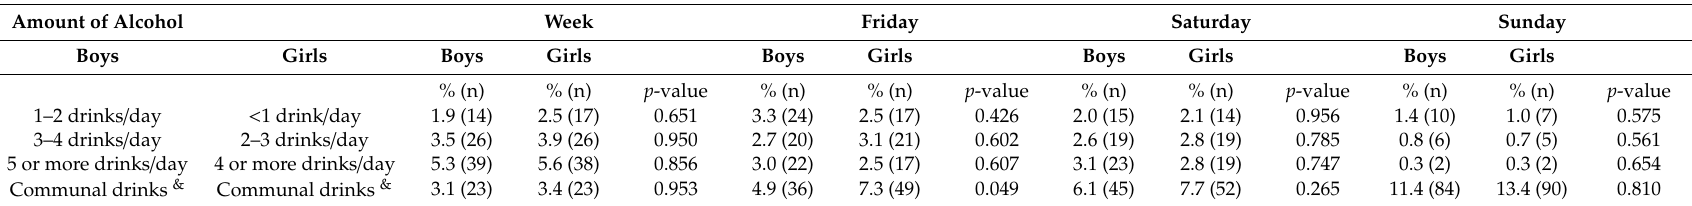
Table 2. The amount of alcohol taken by Ellisras rural children (boys, n = 102 and girls, n = 104) aged 14–22 years during the week and on weekends. Amount of Alcohol